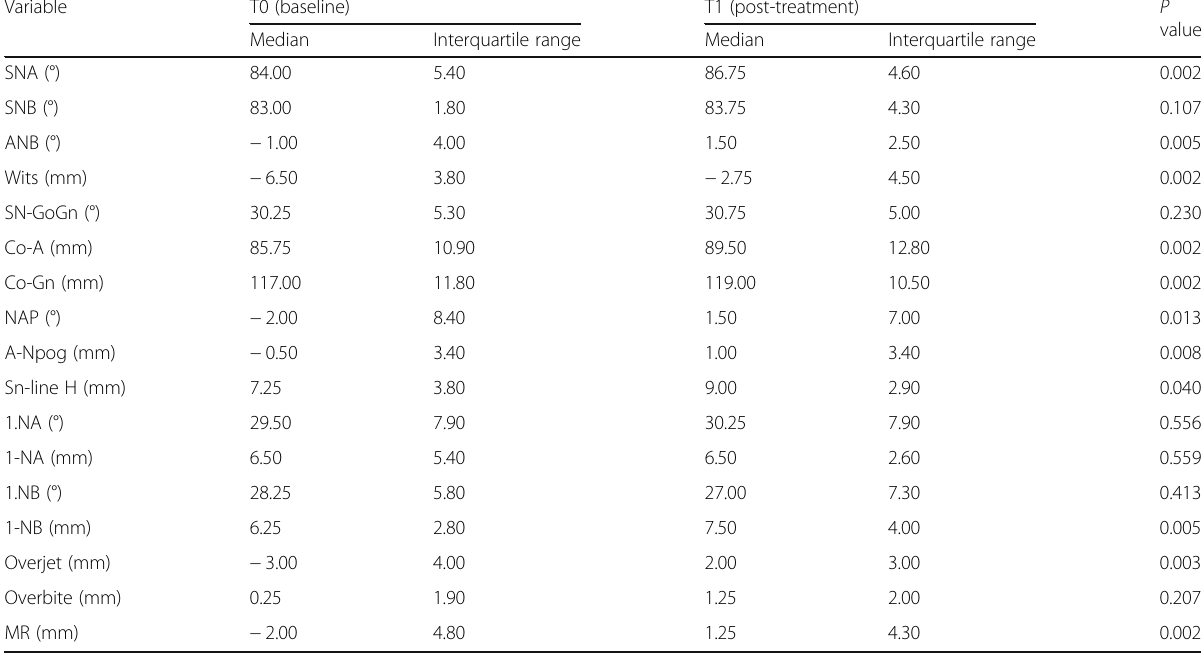
Table 3 Intragroup comparisons (T0 vs. T1) of the facial characteristics for the mini-implant group Variable T0 (baseline) T1 (post-treatment)